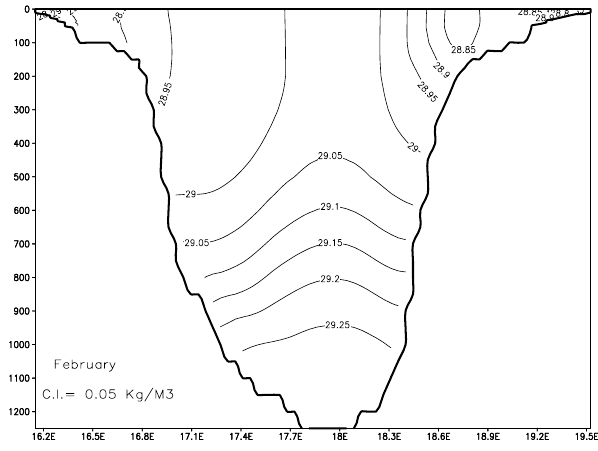
Fig. 12. Adriatic Intermediate Model (AIM). σ θ distribution in February along the zonal section A of Fig. 1. Contour interval is 0.05kg/m 3